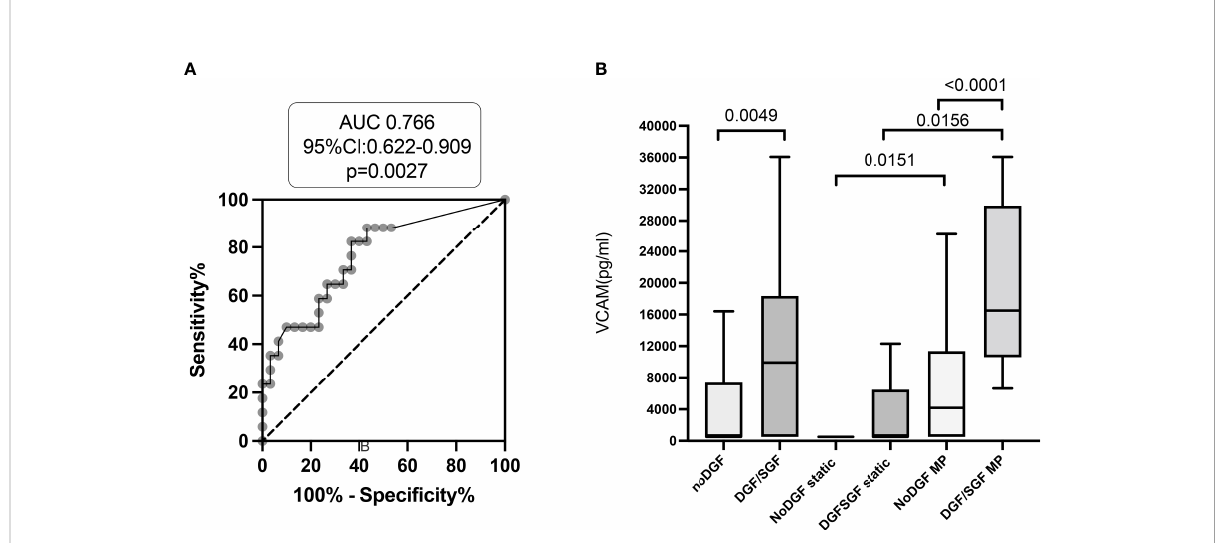
FIGURE 4 VCAM levels evaluated in transplant conservation fl uid associate with early graft dysfunction. (A) . Receiver operating characteristic analysis of the value of VCAM levels predicting early graft dysfunction of ECD transplants at 7 days post-transplant surgery. Area under the curve (AUC) and 95% con fi dence intervals of prediction models are indicated. (B) . Enhanced VCAM values are observed in conservation fl uid of machine- perfused transplants with delayed or slow graft dysfunction by day 7. p values were considered signi fi cant at <.05.